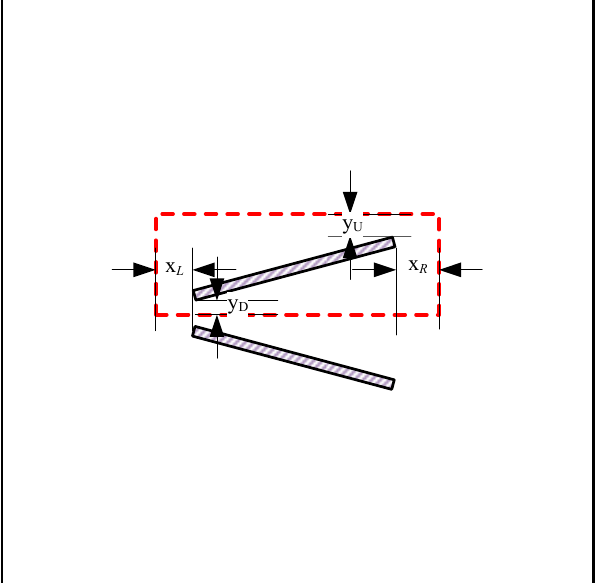
Figure 5. Schematic of the numerical model with an integral domain containing one particle.